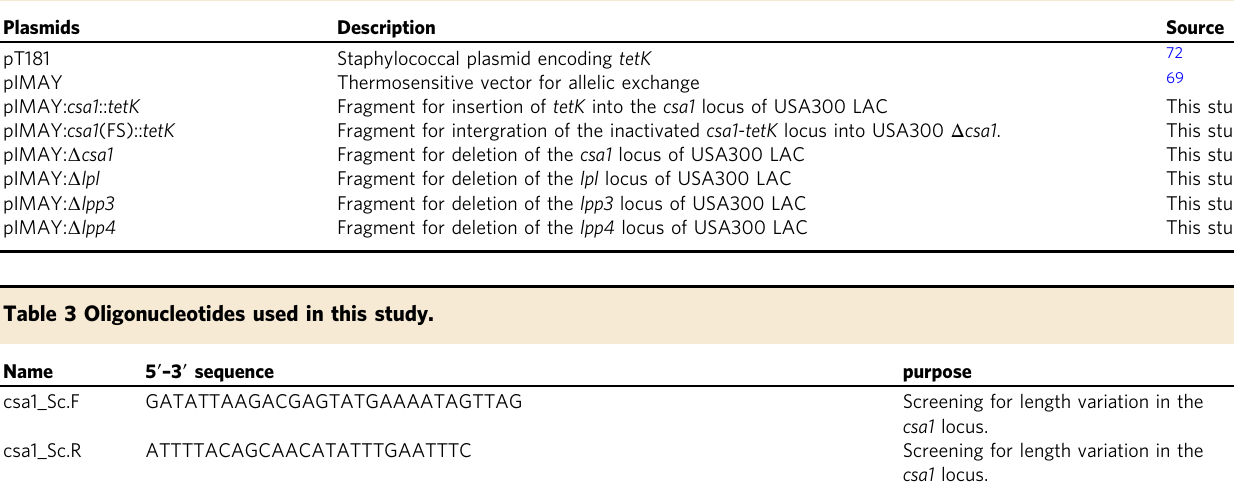
Table 2 Plasmids used in this study.